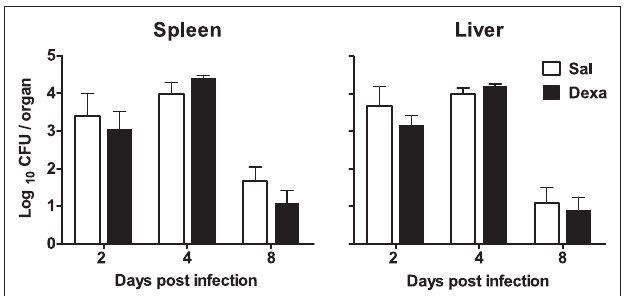
FIgure 8 | No differences in susceptibility to L. monocytogenes infection were observed between Sal and Dexa rats. The bacterial loads of Sal and Dexa rats infected with L. monocytogenes were determined at 2, 4, and 8 days post infection in spleen and liver. Data are represented as the mean + SEM from seven to nine rats per group.